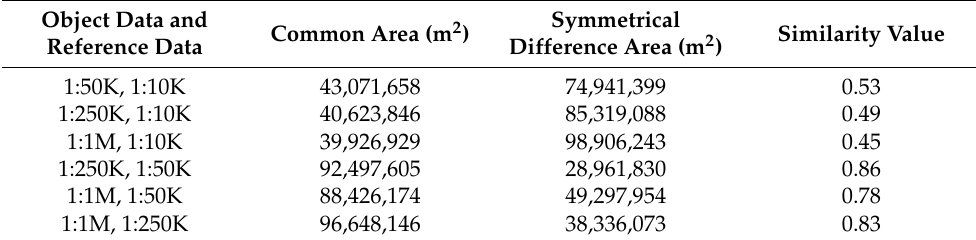
Table 2. Similarity values between residential areas at four